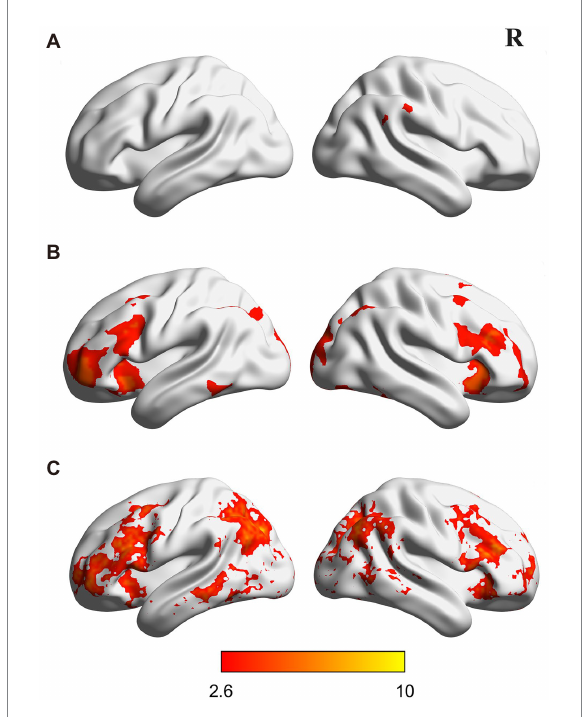
FIGURE 3 Brain regions showing different activations (A,B) and multivoxel activation patterns (C) across the two types of characters (i.e., assembled and addressed characters). All activations were thresholded at p < 0.005 (whole-brain corrected). R,